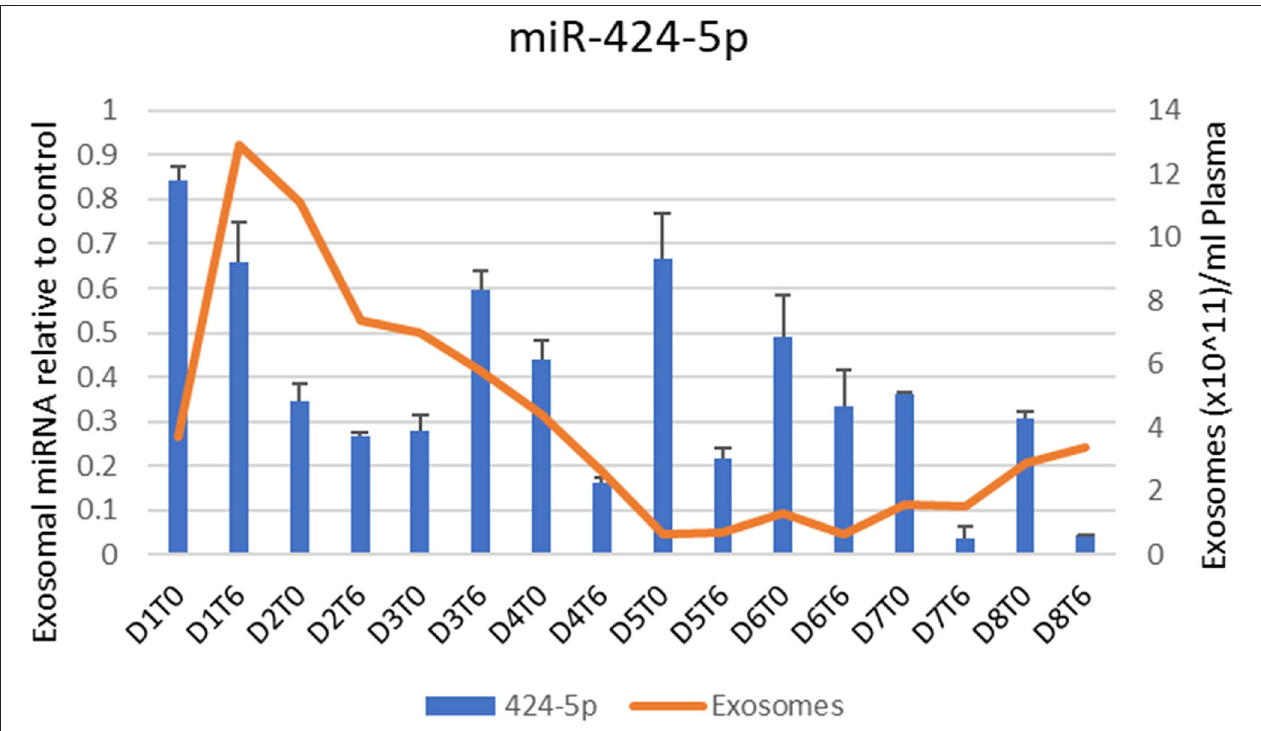
FIGURE 3 | Exosome and Exosomal miR-424 quantification over time in Case